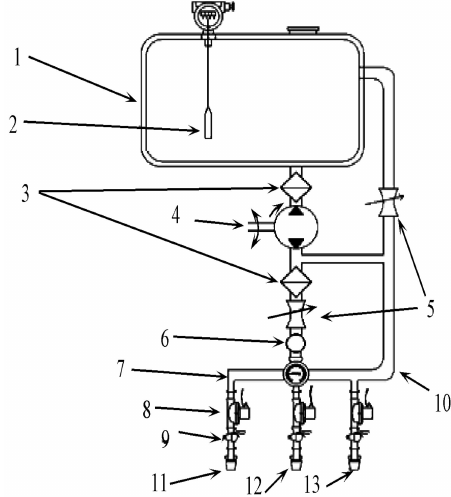
Figure 4. Multi-nozzle variable-rate spraying sub-system of the VRHS control system. 1. Herbicide tank; 2. Liquid level sensor; 3. Filter; 4. Diaphragm pump; 5. Safety valve; 6. Pressure sensor;